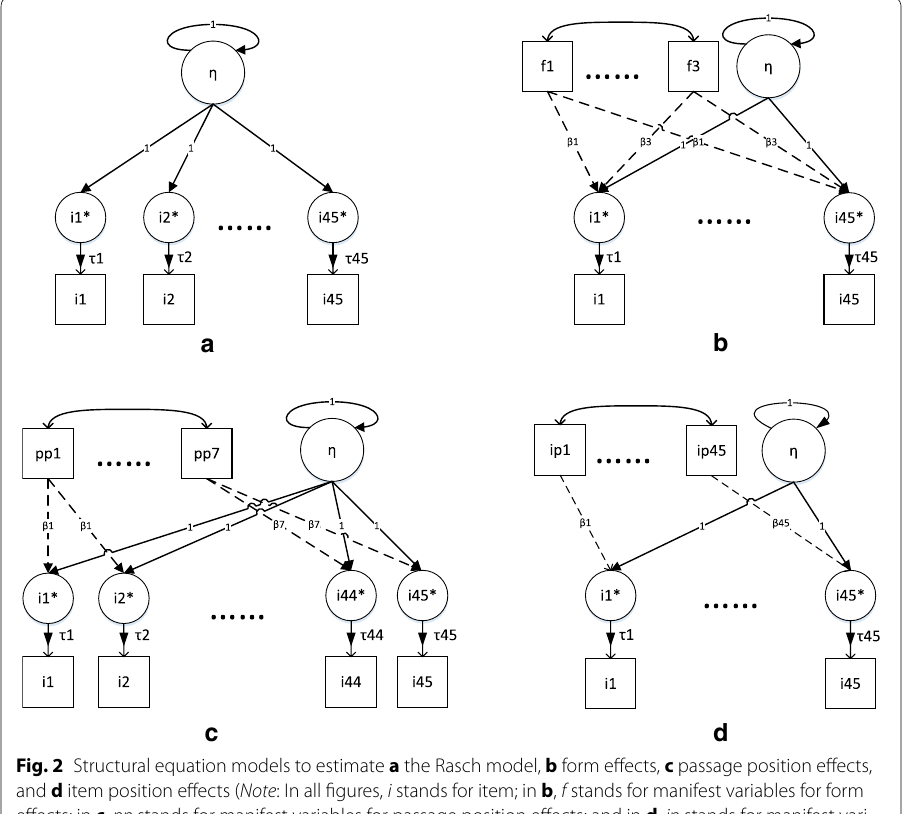
Fig. 2 Structural equation models to estimate a the Rasch model, b form effects, c passage position effects, and d item position effects ( Note : In all figures, i stands for item; in b , f stands for manifest variables for form effects; in c , pp stands for manifest variables for passage position effects; and in d , ip stands for manifest vari- ables for item position